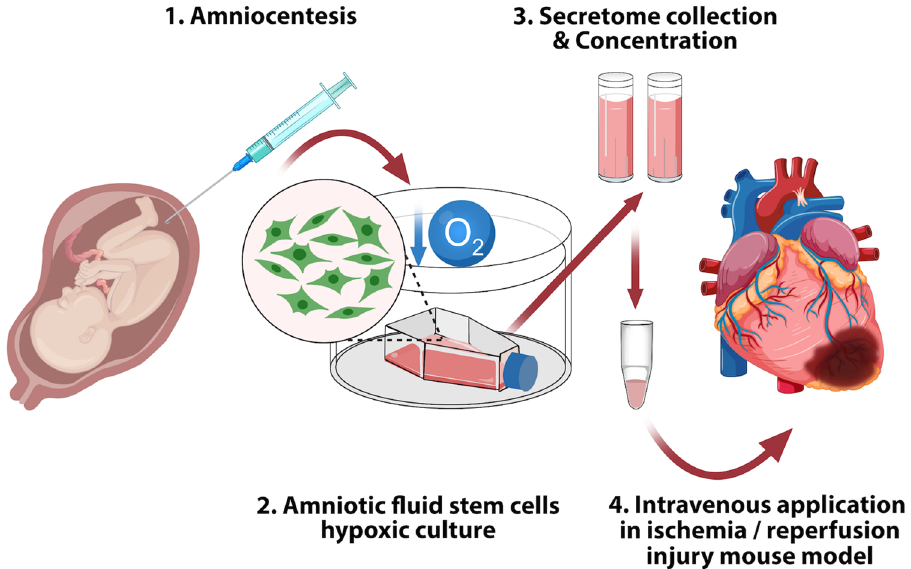
Figure 7. Graphical schematic of experimental